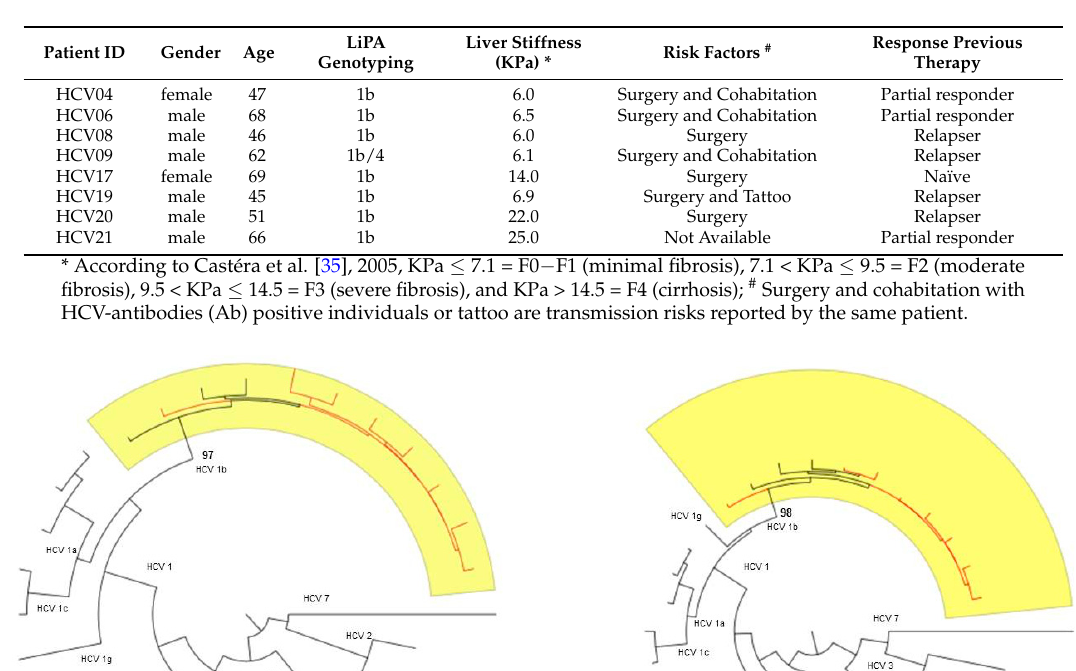
Table 1. Patients’ characteristics.